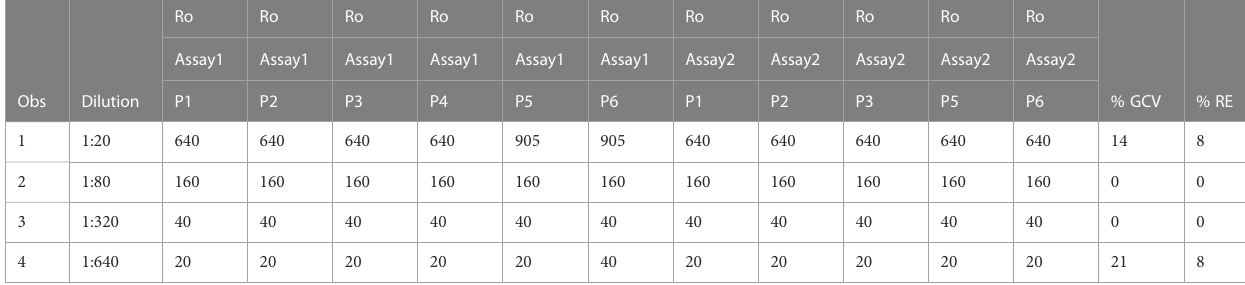
TABLE 7 HAI assay quali fi cation on H3N2 in fl uenza strain A/Texas/71/2017, robustness testing, %GCV and %RE results.